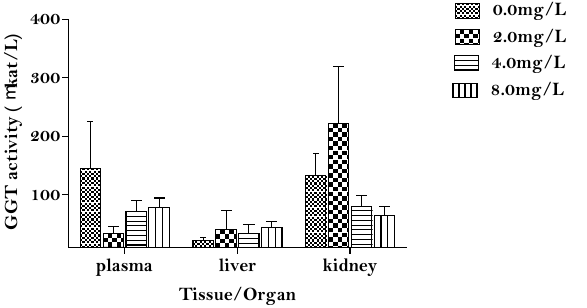
Fig. 3. Lactate dehydrogenase activity of Clarias gariepinus ex- posed to sublethal concentrations of chromium after 7 days. Symbol as presented in Fig.